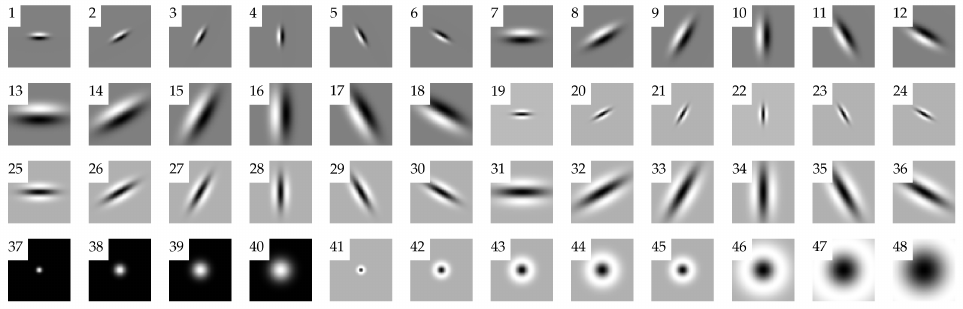
Figure 10. The ‘LM’ filter bank: even (1–18) and odd (19–36) Gaussian derivative filters at three scales (half-octave spacing) and six orientations (equal spacing from 0 to π ), four Gaussian filters (37–40) and eight Laplacian of Gaussian filters